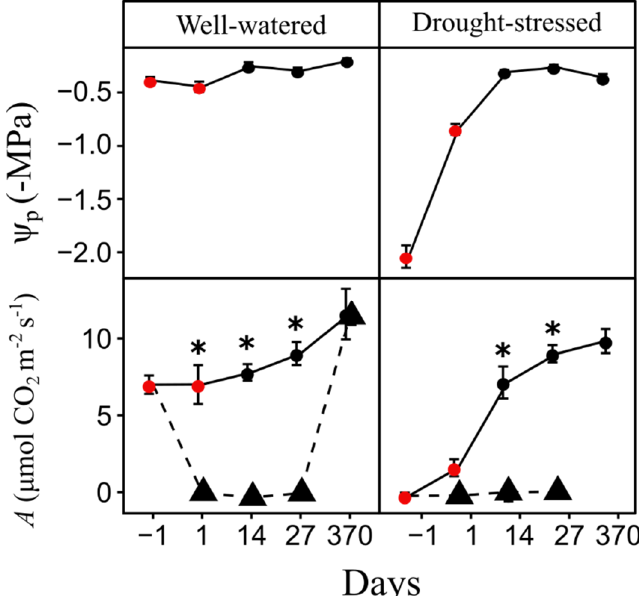
Figure 1. Mean predawn leaf water potential (Ψ p ) and photosynthesis ( A ) in unburned (circle) and burned (triangle) Pinus ponderosa saplings. Ψ p values are only reported for the unburned treatment and A data shows results for control and 0.7 MJ m − 2 treatments. Asterisks denote days where Ψ p and A significantly di ff ered (* P < 0.05) between unburned and burned saplings in each water status treatment. Red circles denote days where Ψ p and A significantly di ff ered ( P < 0.05) between well-watered and drought-stressed saplings in each fire treatment. Bars are SE.